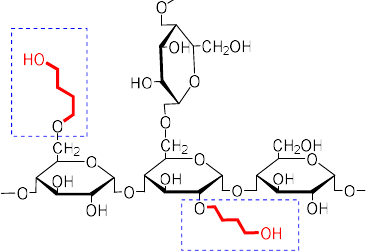
Figure 1. Chemical structure of δ-hydroxybutyl starch.